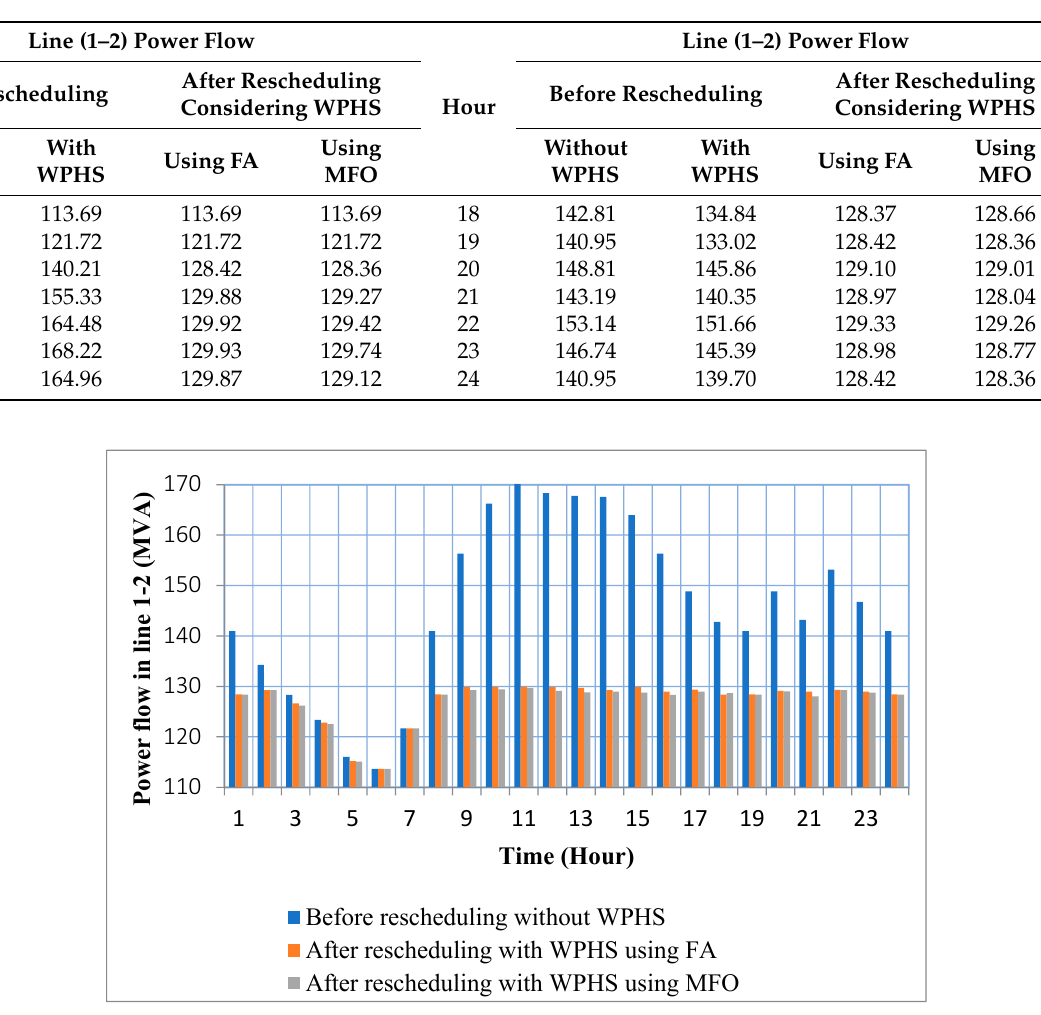
Table 4. Congested line (1–2) power flow before and after rescheduling with and without WPHS